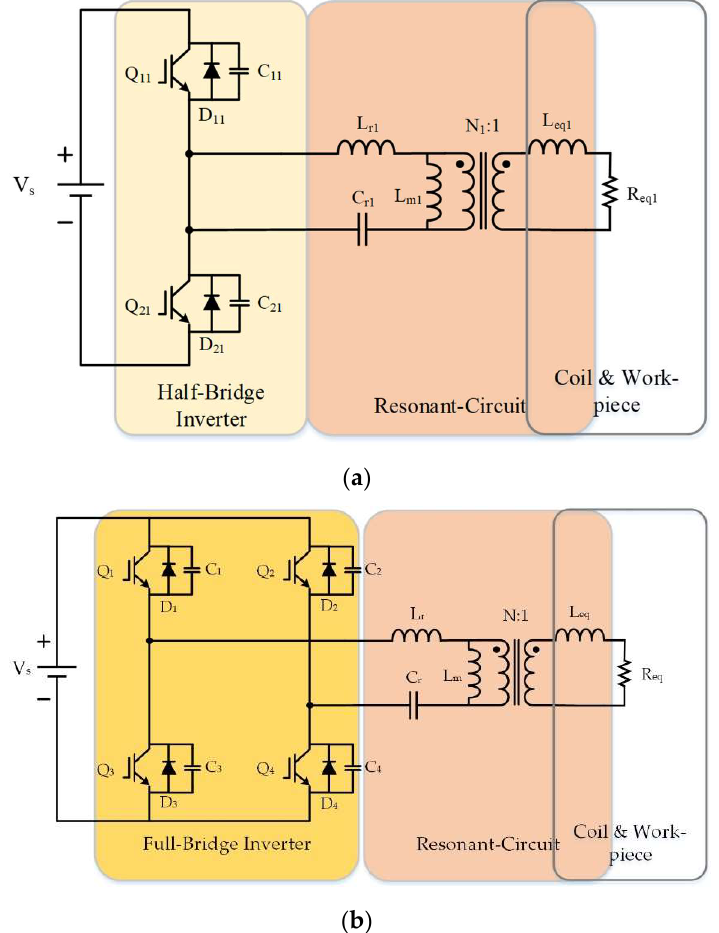
Figure 6. Architecture diagram of the LC series resonant converter: ( a ) half-bridge, ( b ) full-bridge.